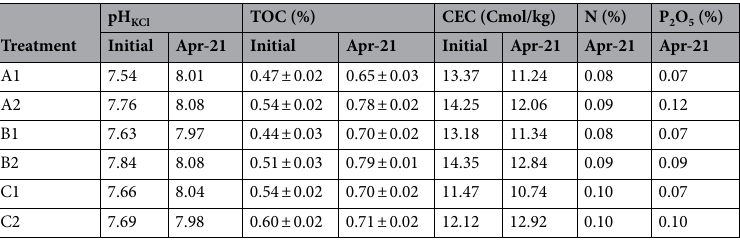
Table 3. Properties of soils at different experimental lots during the trial.